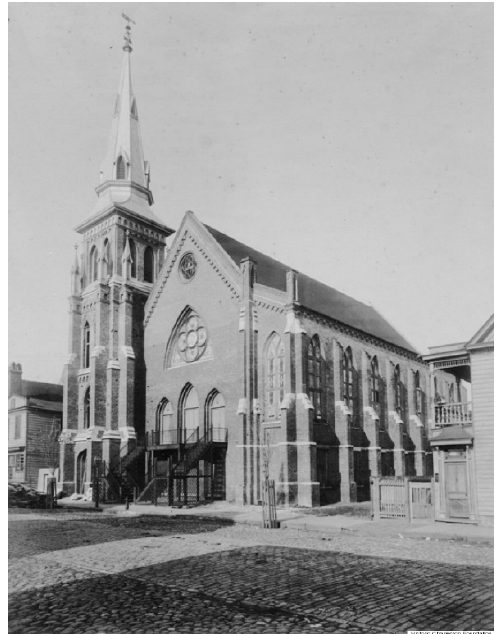
Figure 15. Emanuel AME Church circa 1910. Image courtesy of the Avery Research Center at the College of Charleston.